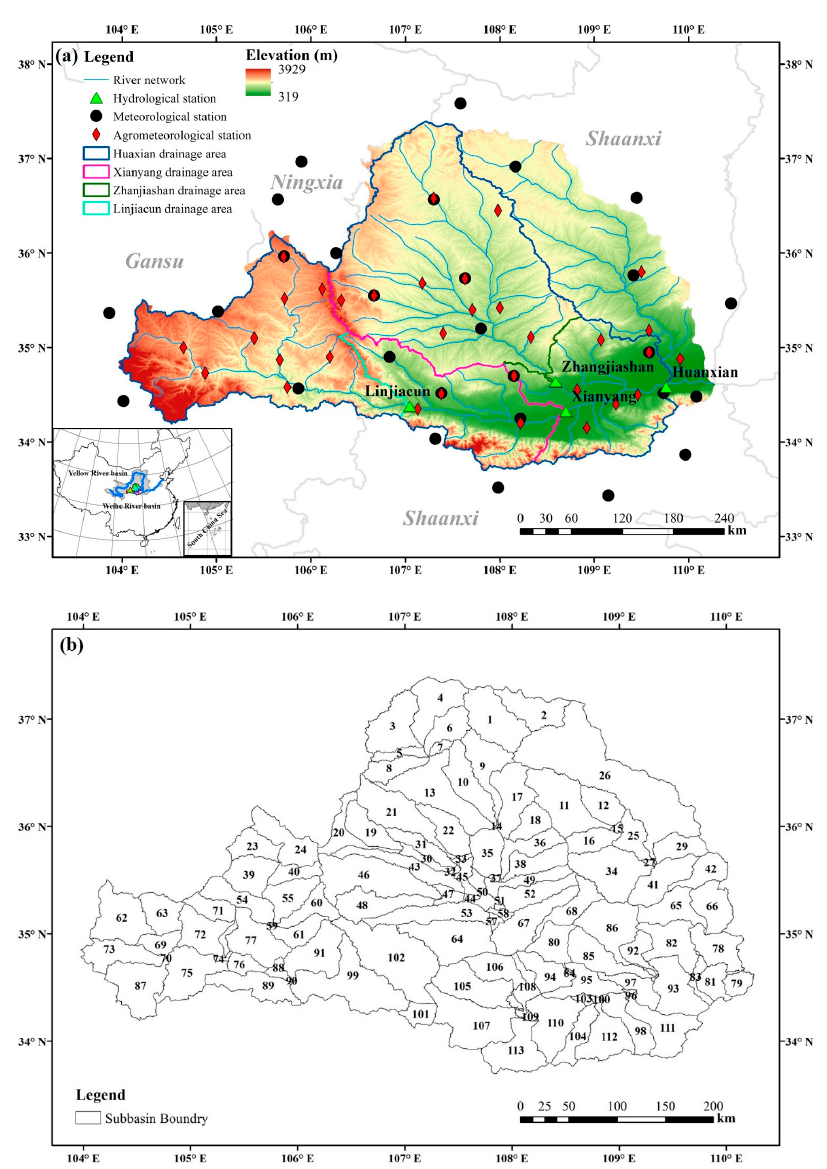
Figure 1. ( a ) Location, topography, river systems and distribution of stations in the Wei River Basin (WRB); ( b ) The sub-basin delineation of the WRB.